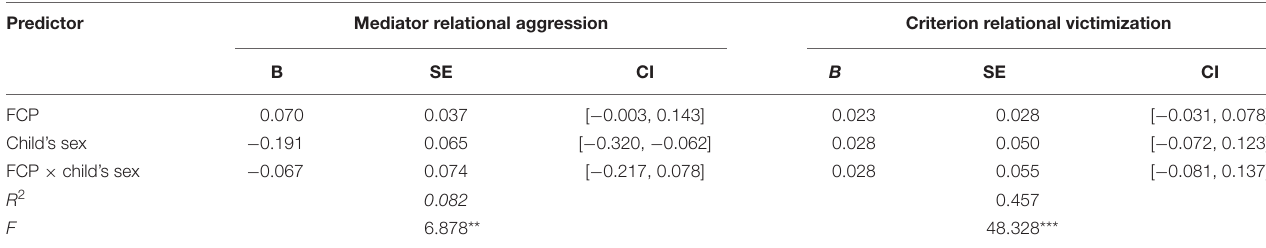
Predictor Mediator relational